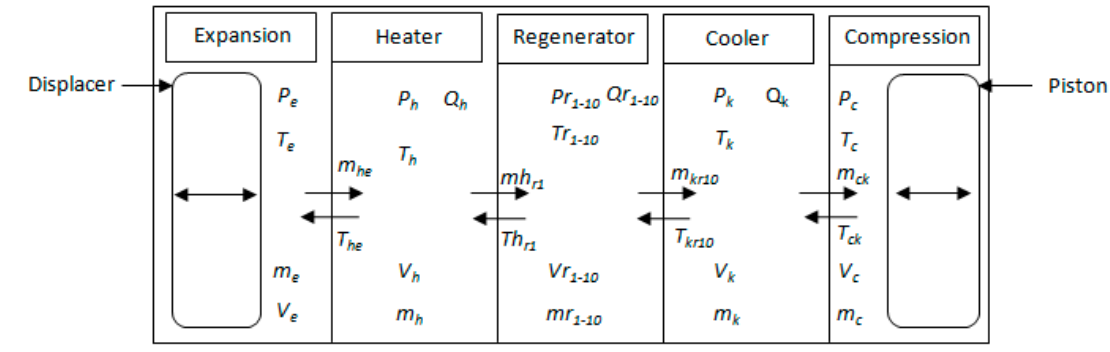
Figure 2. The control volumes of the FPSE [30].